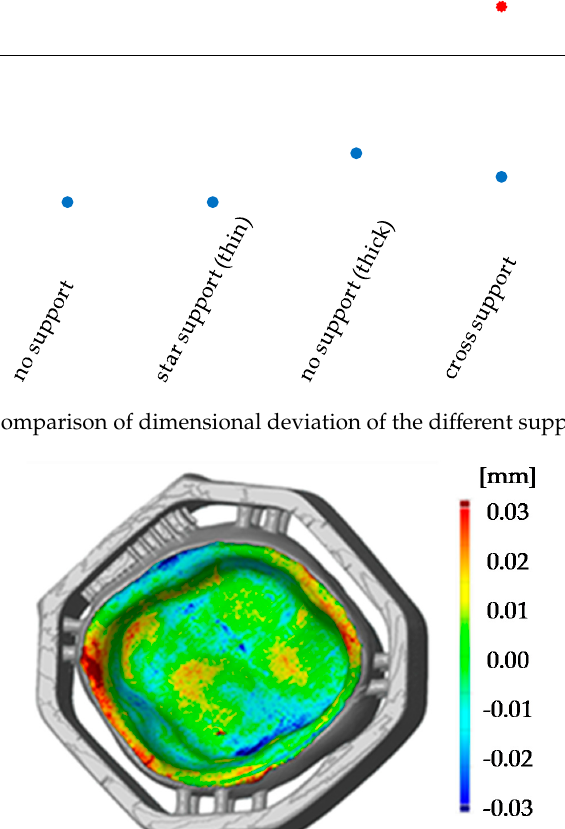
Figure 9. Comparison of dimensional deviation of the different support designs.